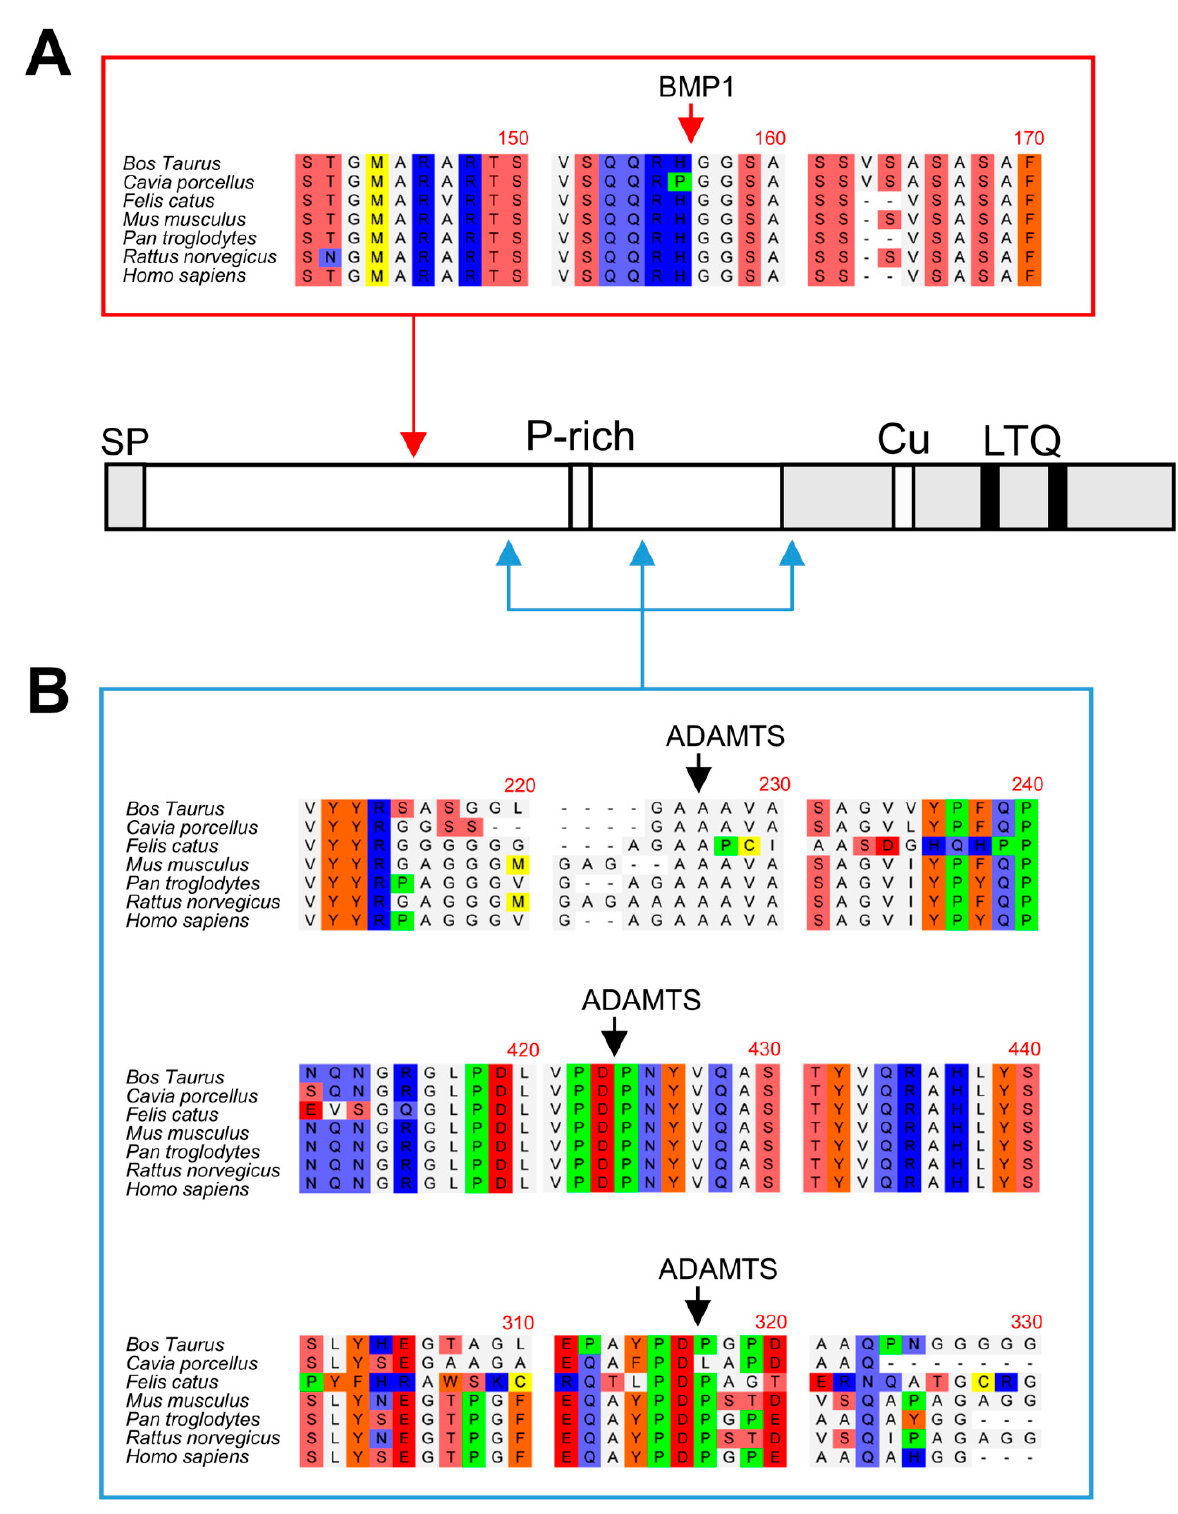
Figure 6. Multiple sequence alignments of BMP1 and ADAMTS14 cleavage sites. Sequence alignment of LOXL1 orthologs from the indicated species showing high homology at the BMP1 ( A ) and ADAMTS14 ( B ) cleavage sites. Protein alignments were done with the ClustalW2 program (http://www.ebi.ac.uk).